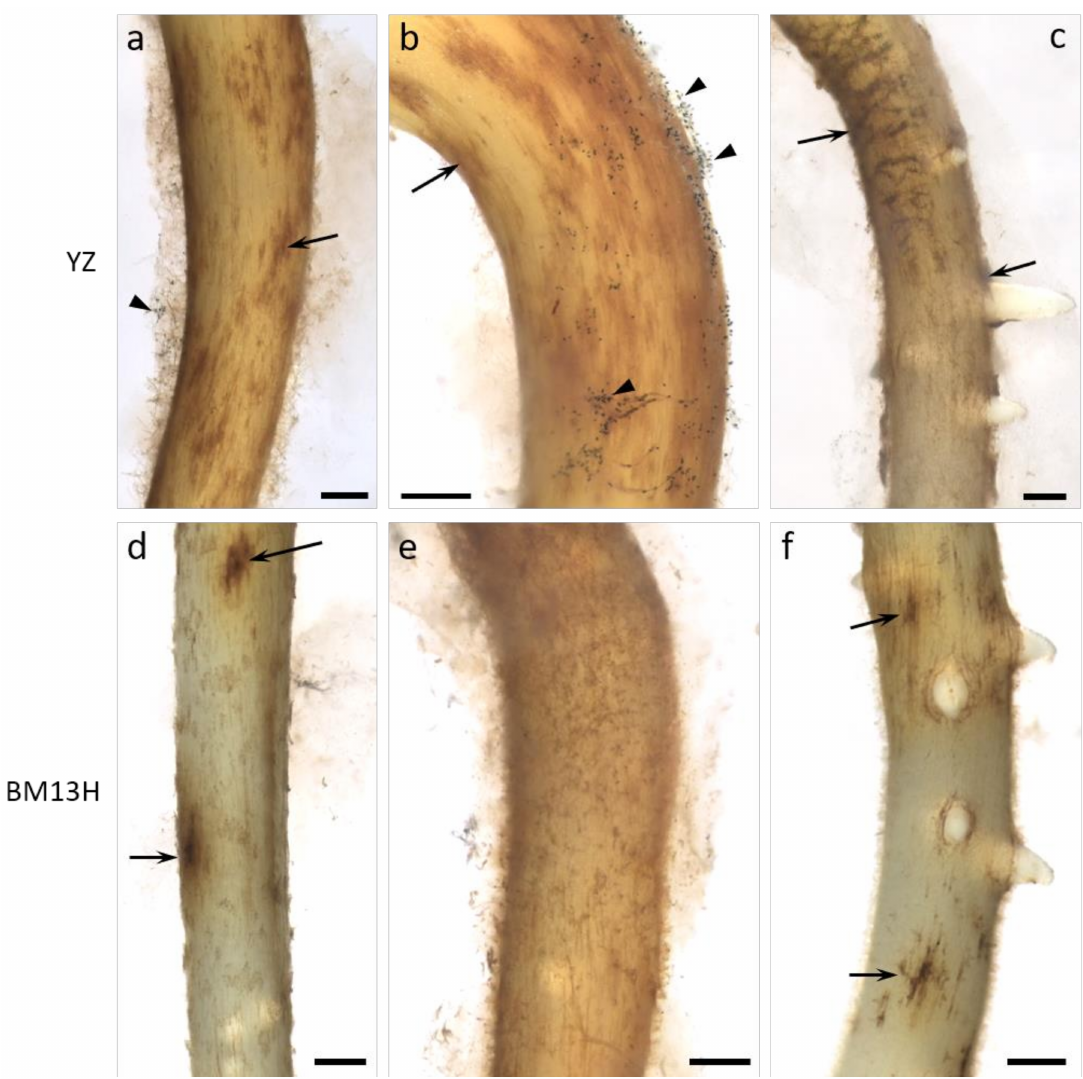
Figure 2. Surface views of roots from susceptible (YZ— a – c ) and resistant (BM13H— d – f ) G. arboreum seedlings 5 days after inoculation with BRR spores in sterile culture. The roots became colonized in both accessions (black and brown patches, small arrows), but fungal growth is much more advanced on YZ roots, with abundant spores (arrowheads) already formed and more extended root blackening evident. Some BM13H roots support considerable fungal growth ( e ), but little sporulation. Bars = 0.5